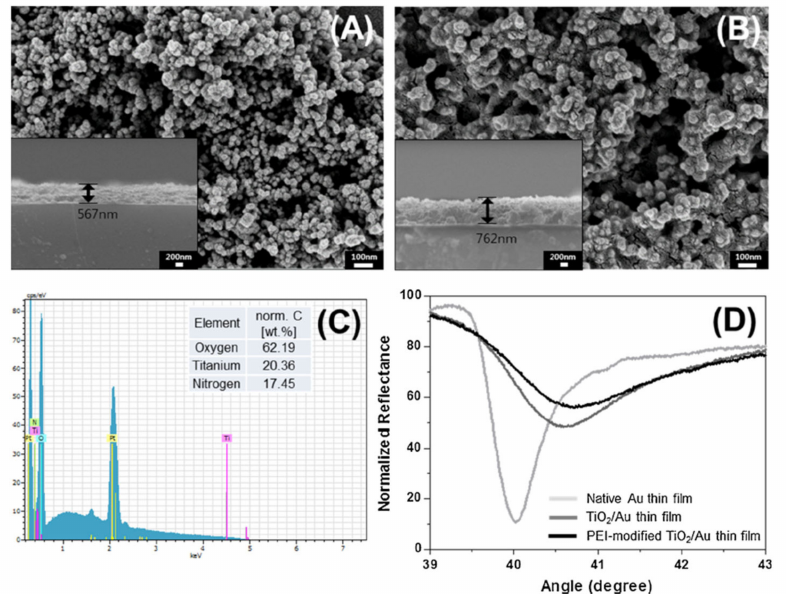
Figure1. SEMimagesofthemodifiedthinfilmsdeveloped(( A )and( B )),elementalanalysis( C ),andresult obtained with the surface plasmon resonance (SPR) technique for the detection of formaldehyde ( D ). Reproduced from [13] with permission from Elsevier (License number